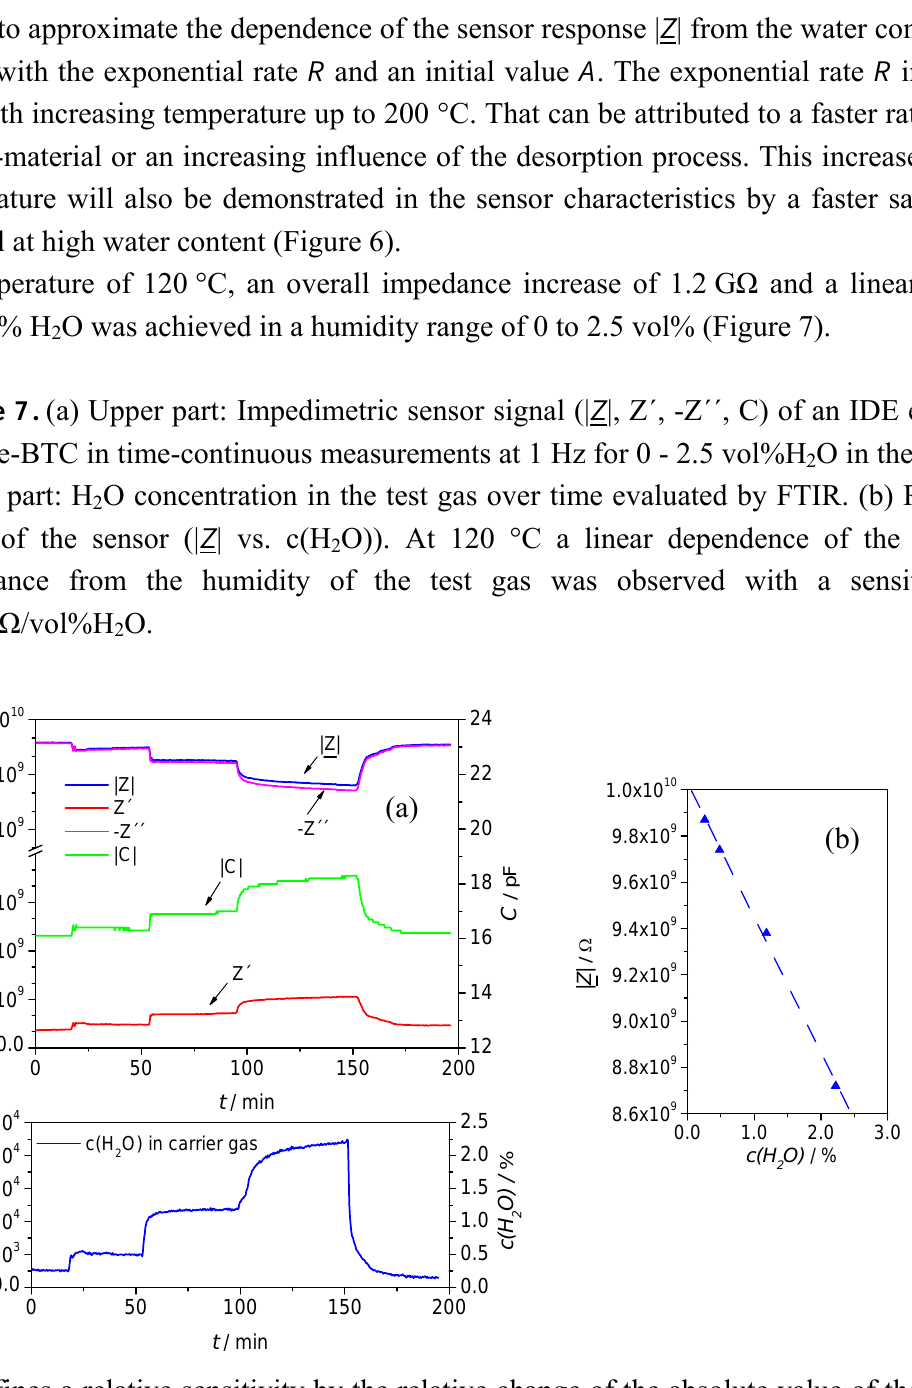
O in the test gas. 2